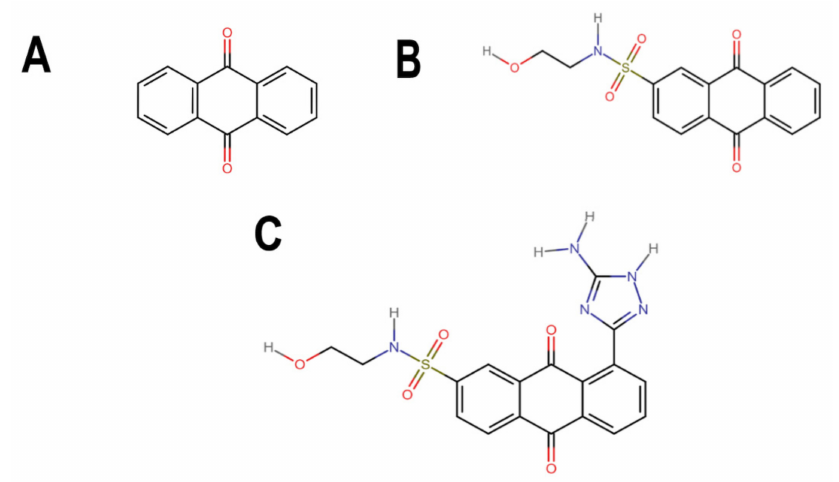
Figure 5. Chemical structures of molecules used in prediction analysis. ( A ) The anthraquinone core without functional groups, AC. ( B ) The best-scored anthraquinone, BS-1 and ( C ) The designed anthraquinone,